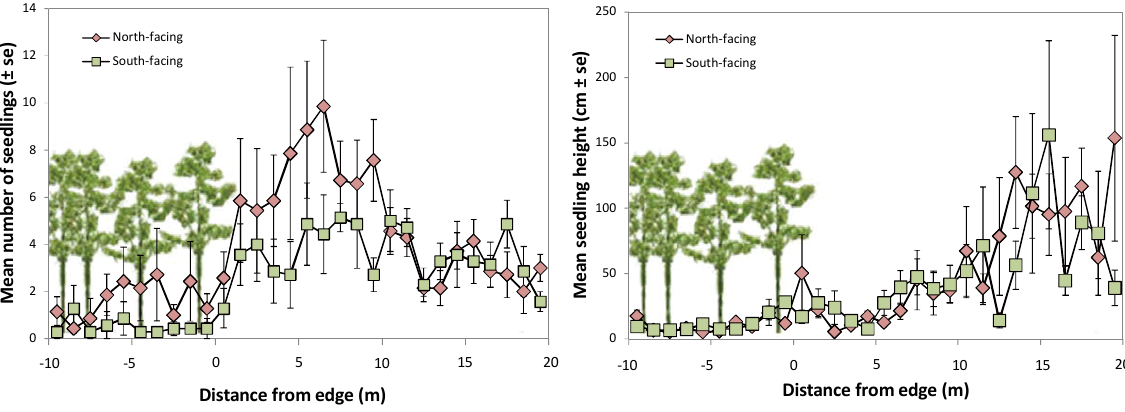
Figure 2. Spatial patterns of the number of pine seedlings per m − 2 and their mean height (cm) along 30-m transects going from inside the forest stand, out into forest gaps. On the x -axis, 0 m denotes the forest edge. The forest edges faced either north or south.